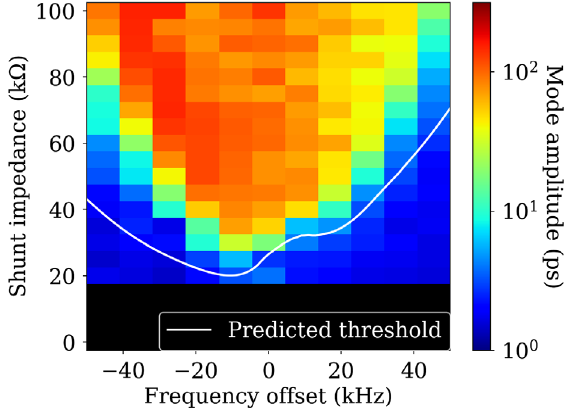
FIG. 7. Bunch motion observed in macroparticle tracking compared to the threshold shunt impedances predicted by theory for point bunches. The black pixels are points for which no simulation was